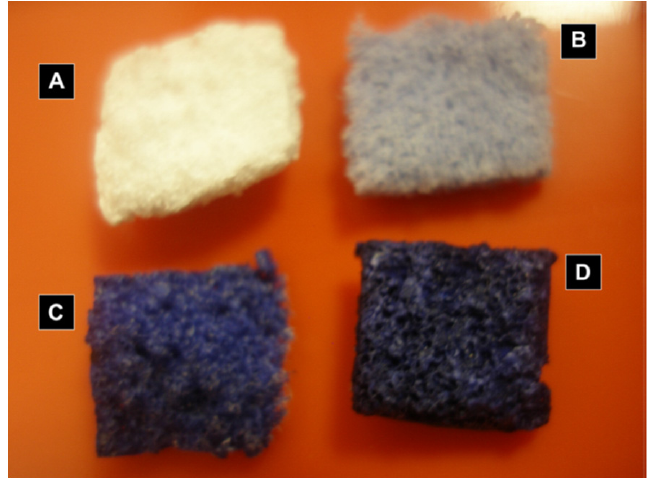
Figure 21. Adapted with permission from M.G. Raucci et al. [93]. Copyright 2010 Elsevier. License number 5318831137579. ( A ) PCL scaffold, ( B ) HAp/PCL scaffold, ( C ) HAp/PCL scaffold after 3 days